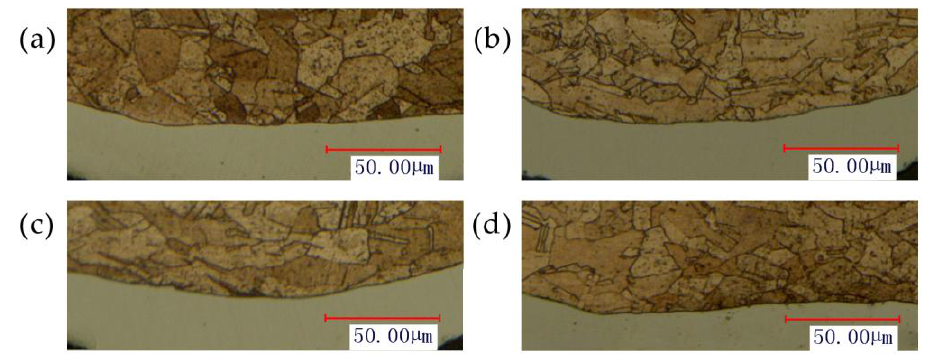
Figure 21. The microstructure at 25 °C and different energy: ( a ) 720 mJ, ( b ) 1080 mJ, ( c ) 1440 mJ and ( d ) 1800 mJ.